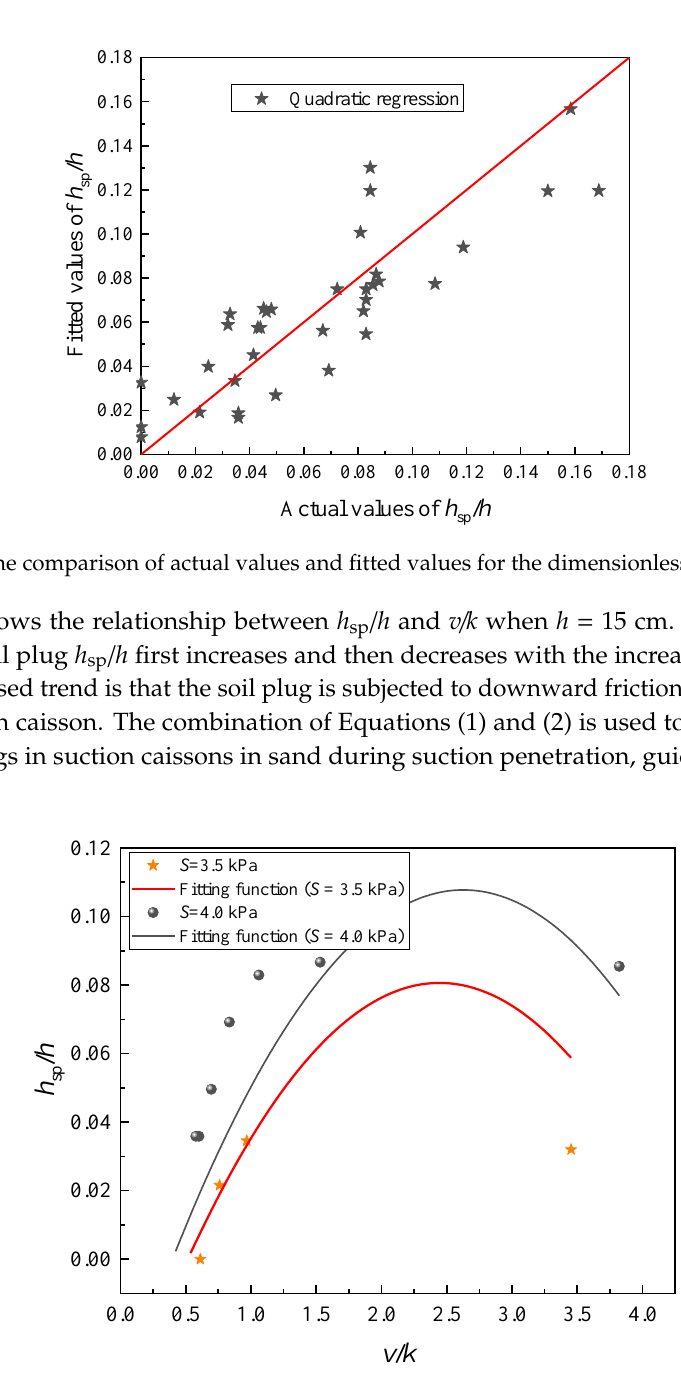
Figure 11. The relationship between h sp / h and v / k when h = 15 cm.